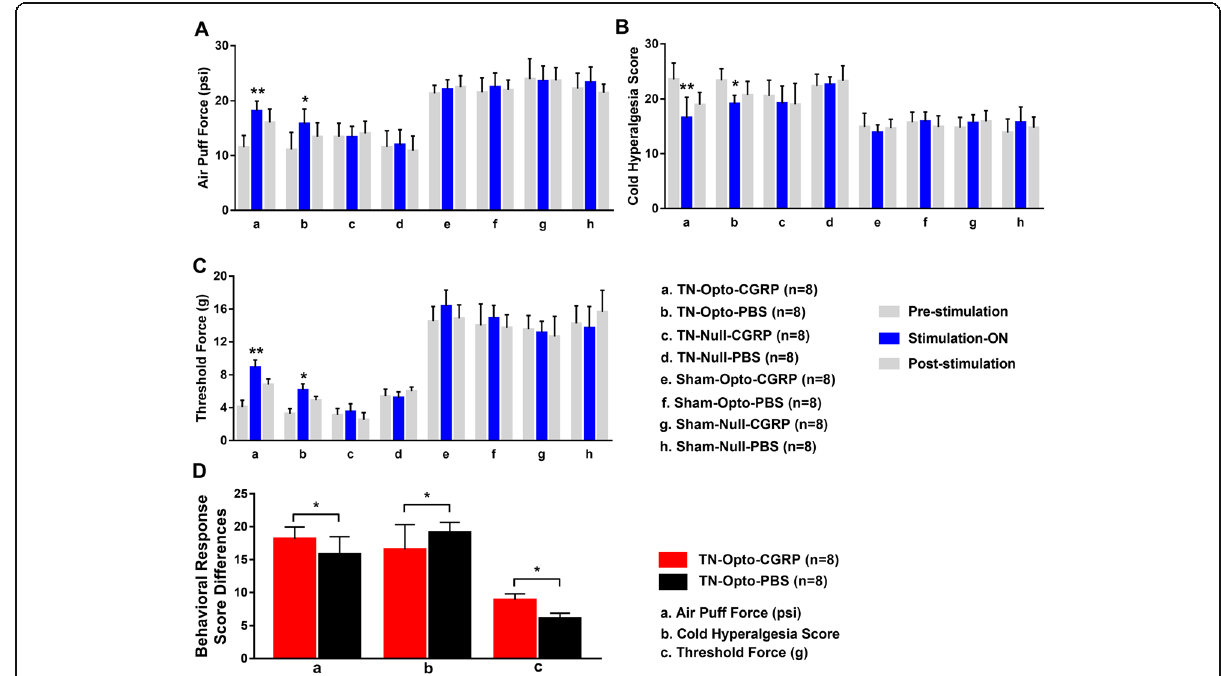
Fig. 4 Changes in behavioral responses following blue laser stimulation ( a - c ) along with knocking down of α -CGRP ( d ). Results for the air-puff test ( a ), cold hyperalgesia test ( b ), and von Frey test ( c ) for all eight animal groups. Only the TN-Opto-CGRP ( a ) and TN-Opto-PBS groups ( b ) exhibited significant changes in behavioral scores during the stimulation ON condition. No significant changes in behavior were observed in other animal groups during the stimulation ON condition. d Animals with α -CGRP injection exhibited more improvement in behavioral tests than animals with PBS injection. a Air puff force differences, b Cold hyperalgesia score differences and ( c ) Mechanical allodynia score differences between TN-Opto-CGRP and TN-Opto-PBS group. *, p < 0.05; **, p < 0.01, significant difference determined via an analysis of variance